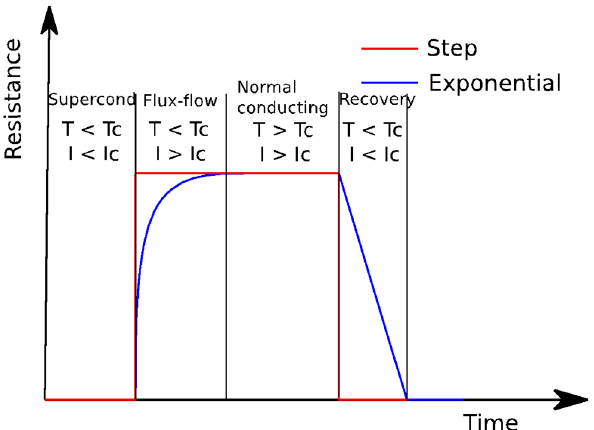
Figure 1. Step and exponential model comparison.